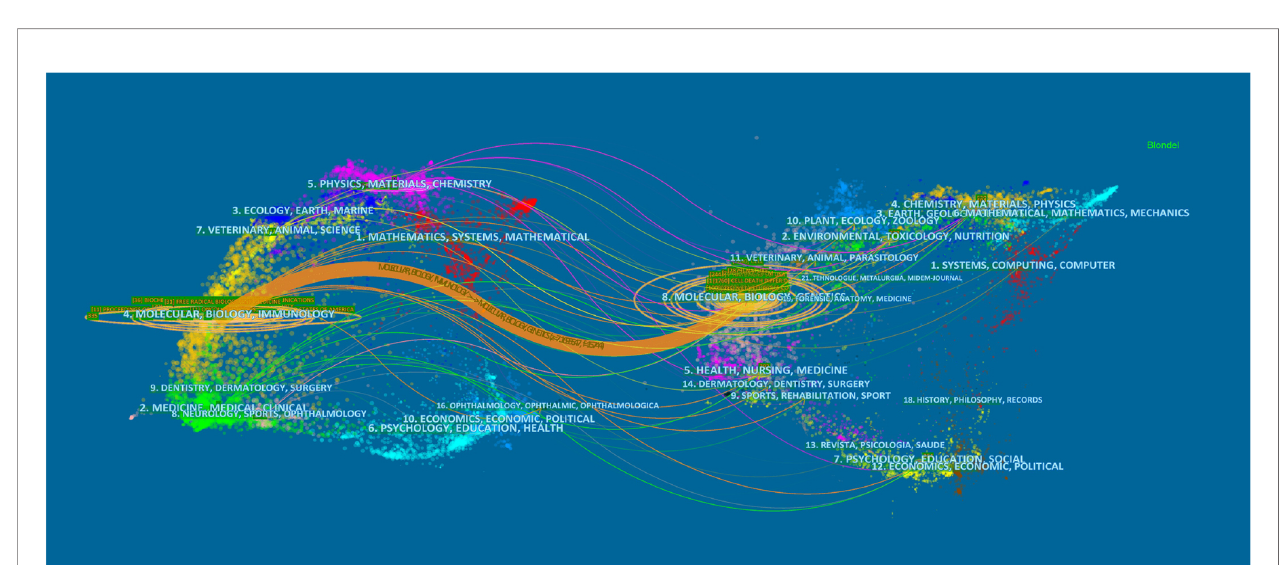
FIGURE 2 | The dual-map overlay of journals related to ferroptosis research. Notes: The citing journals were at left, the cited journals were on the right, and the colored path represents citation